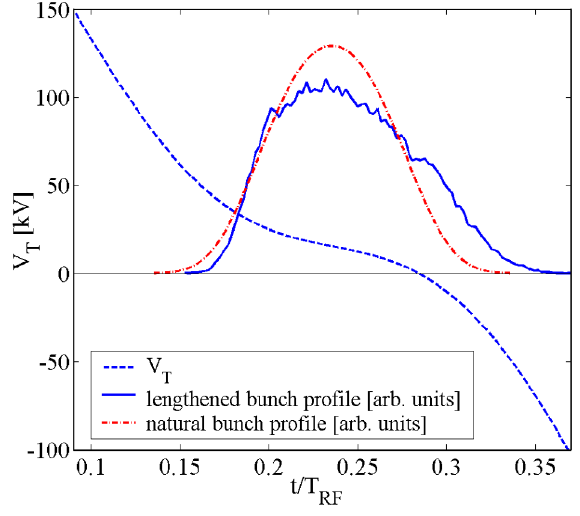
FIG. 2. (Color) Bunch